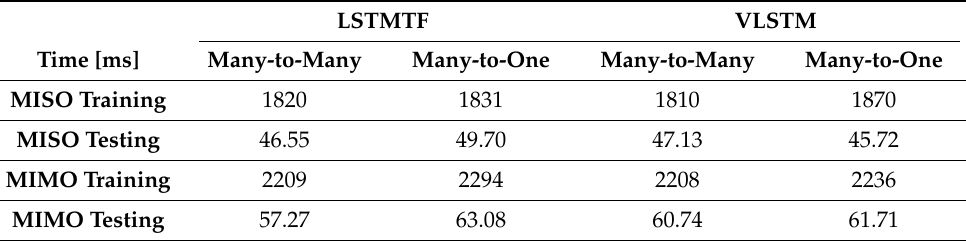
Table 8. The actual training and testing times for 50,000 data points, measured in milliseconds, for LSTMTF and